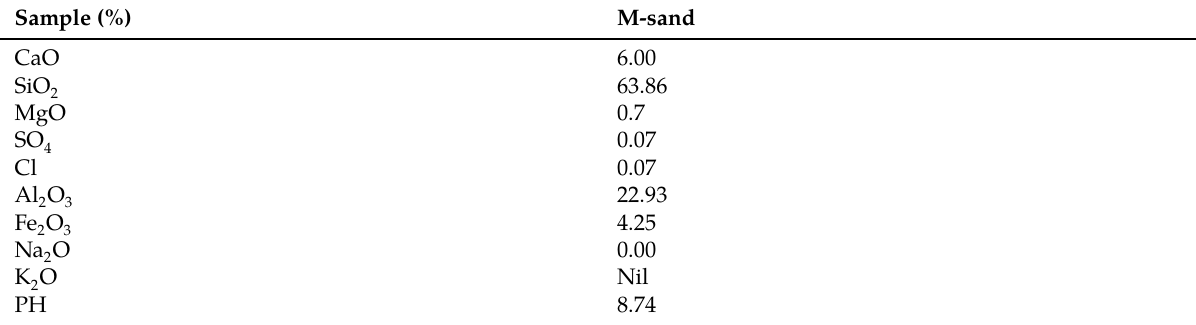
Table 2: Parameters of manufactured sand.